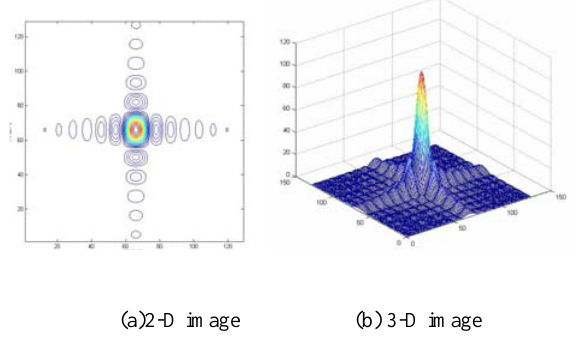
Figure 8. Point target simulation by the presented